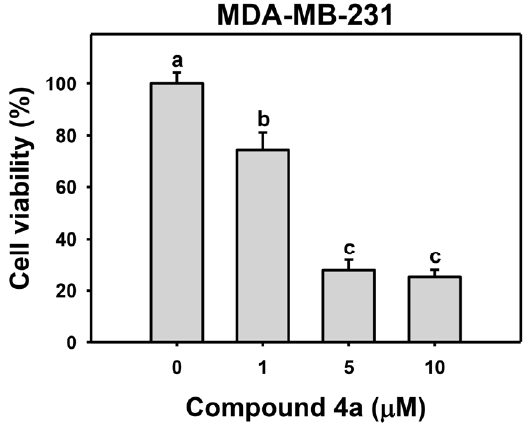
Figure 2. Inhibition of cellular ATP contents of breast cancer cells by compound 4a . MDA-MB-231 cells were treated with 4a for 24 h. Data, means ± SDs ( n = 3). Data containing non-overlapping notes exhibited significant differences ( p < 0.05). The letters (a, b, c) were provided by the statistical JMP software for determine significance. “a” is the biggest value and others follow the order.